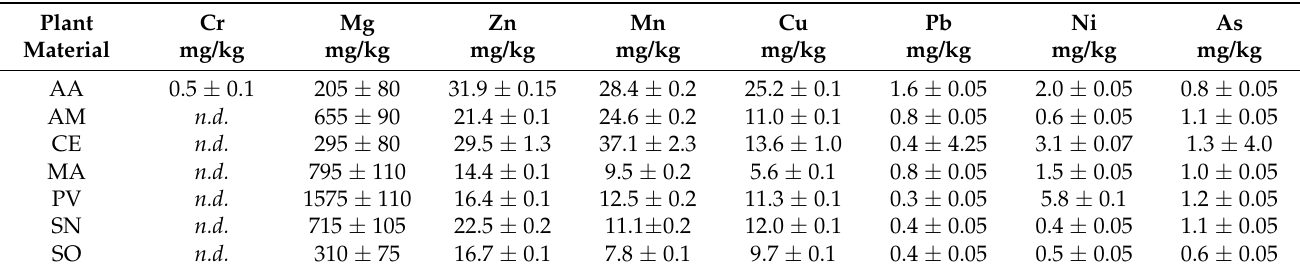
The abbreviations for plant material are presented in Table 2; n.d. = not detected. Values are average of 3 replications ±